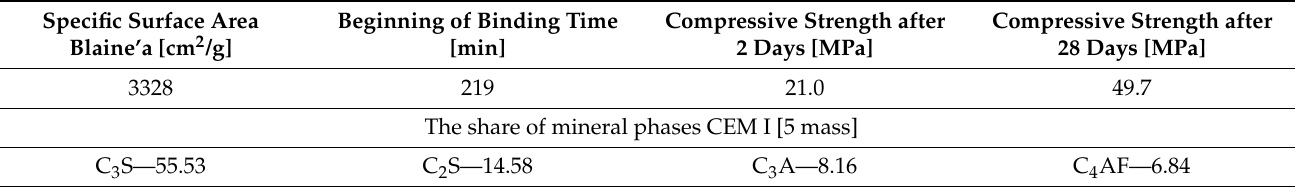
Figure 3. The concrete is crushed into a concrete mixer. Table 1. Physical properties and phase composition of cement CEM I 42.5 R.